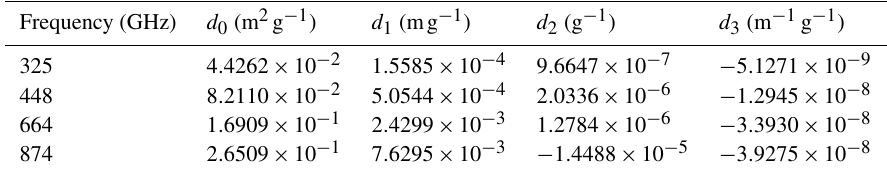
Table A4. Coefficients in the fitting of terahertz mass-averaged absorption coefficients (m 2 g − 1